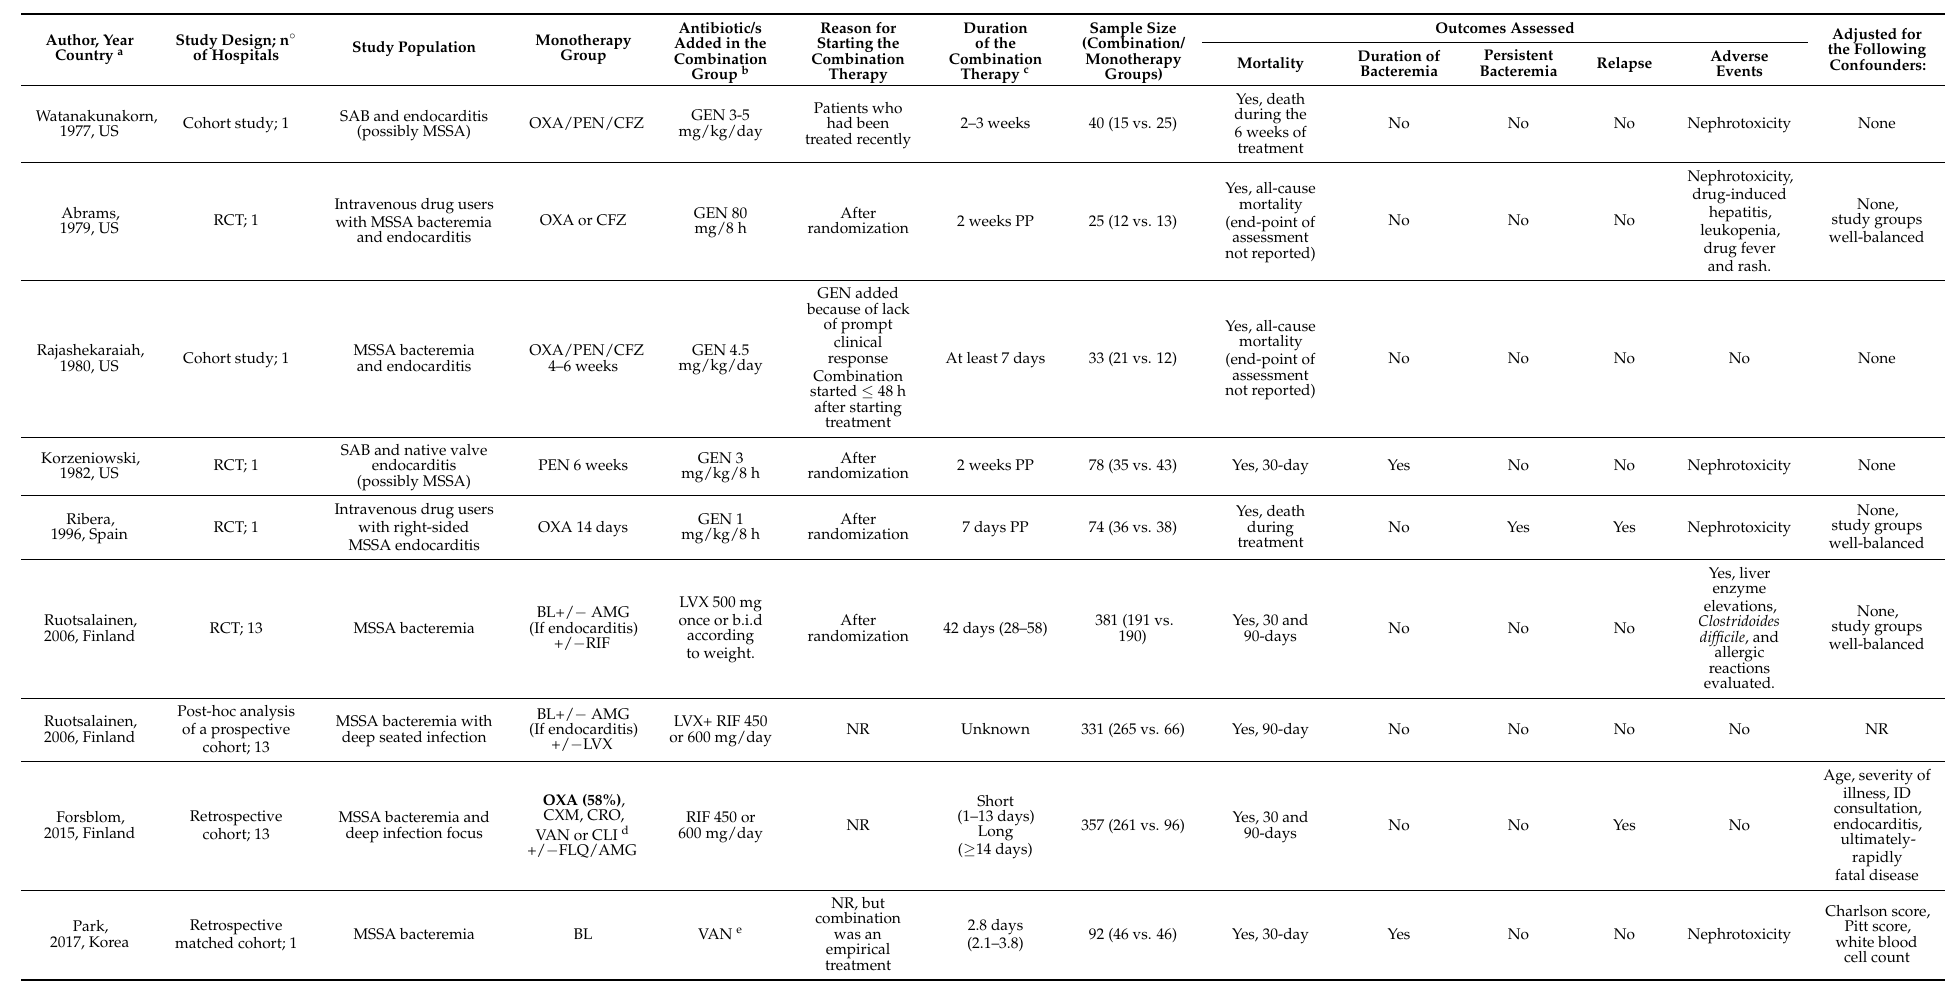
Table 1. Main characteristics of the studies